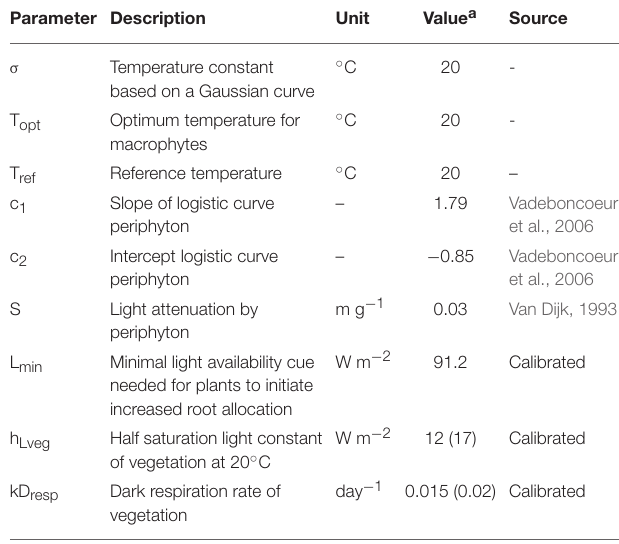
TABLE 3 | Parameter settings for